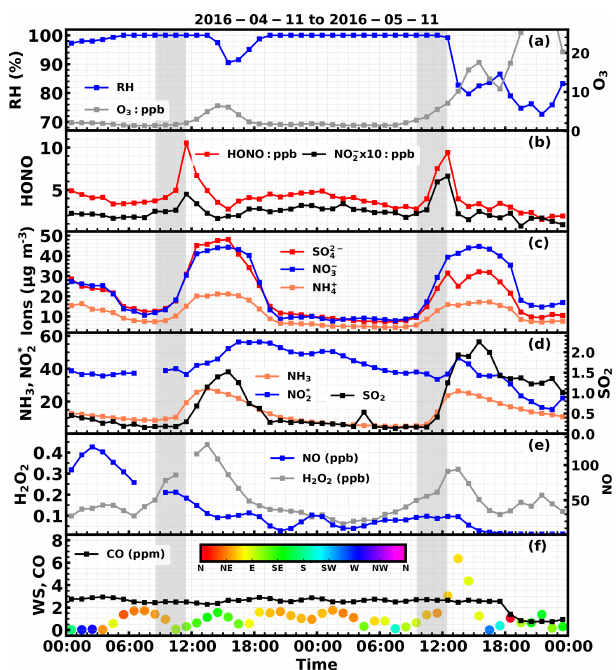
Figure 4. Time series of ambient (a) RH, O 3 , (b) HONO, NO − (c) SO 2 − , NO − , NH + , (d) NH 3 , NO ∗ , SO 2 , (e) NO, H 2 O 2 , (f) CO, 4 3 4 2 wind speed and wind direction (colors of scatter points) from 4 to 5 November. 2016. Gray shaded areas represent periods displaying a rapid increase in